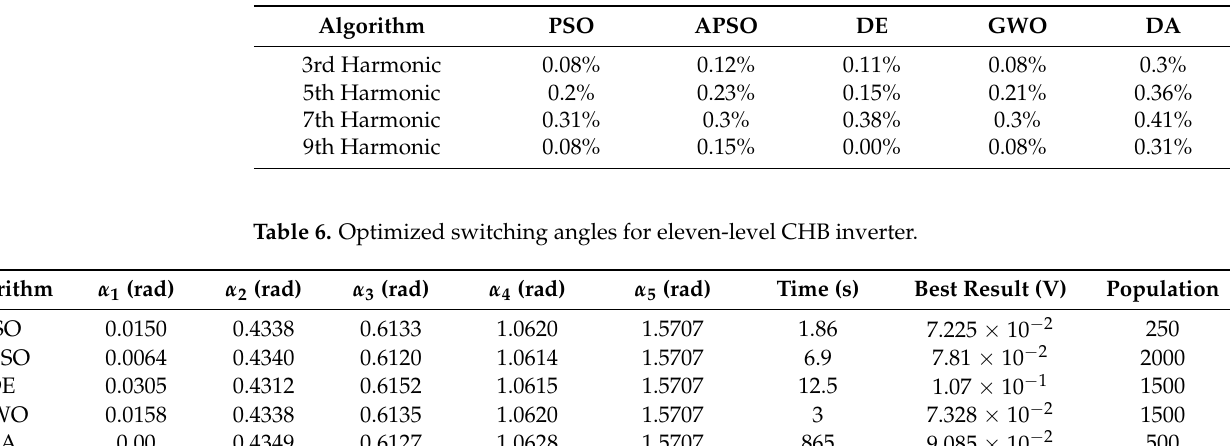
Table 4. Optimized switching angles for nine-level CHB inverter. Table 5. Percentage harmonics (w.r.t. fundamental) for eleven-level CHB inverter.